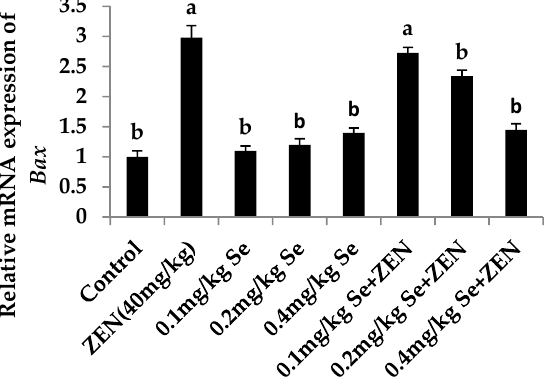
Figure 3. Effect of ZEN, different concentration of Se and their co-treatment on the relative mRNA expression of Bax in mice testicular tissue. Values are mean ± SE of twenty mice in each group. a,b Means with different letters are significantly different, p < 0.05. a p < 0.05 vs. control group, b p < 0.05 vs. ZEN-treated group.